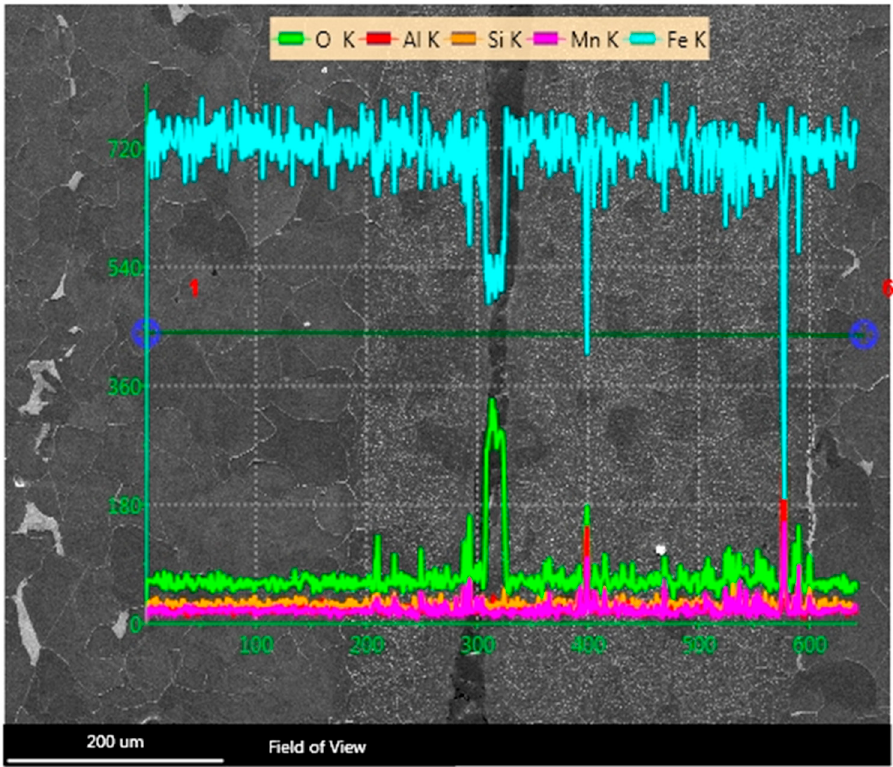
Figure 4. Elemental line scan on top of a crack at the surface of the heavy plate.